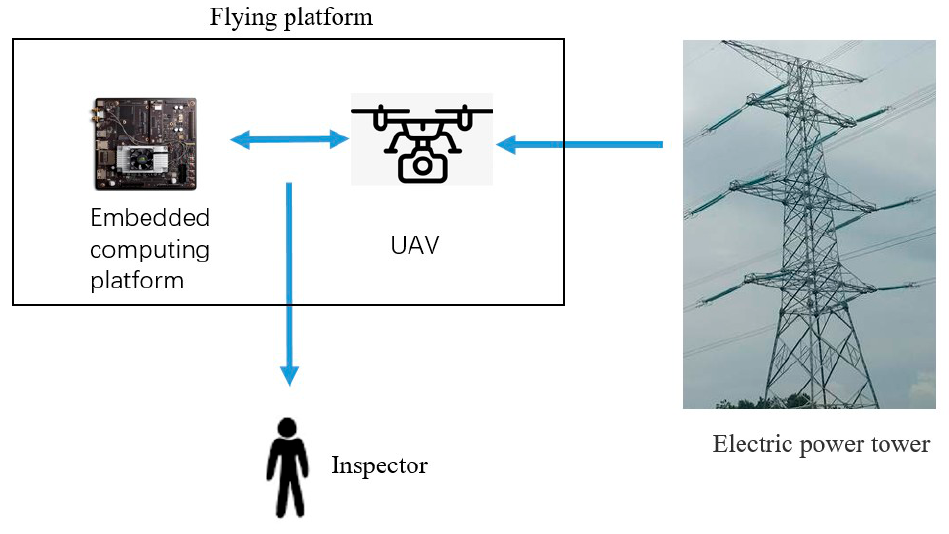
Figure 7. Online Figure 7. Online detection. Figure 7. Online detection.